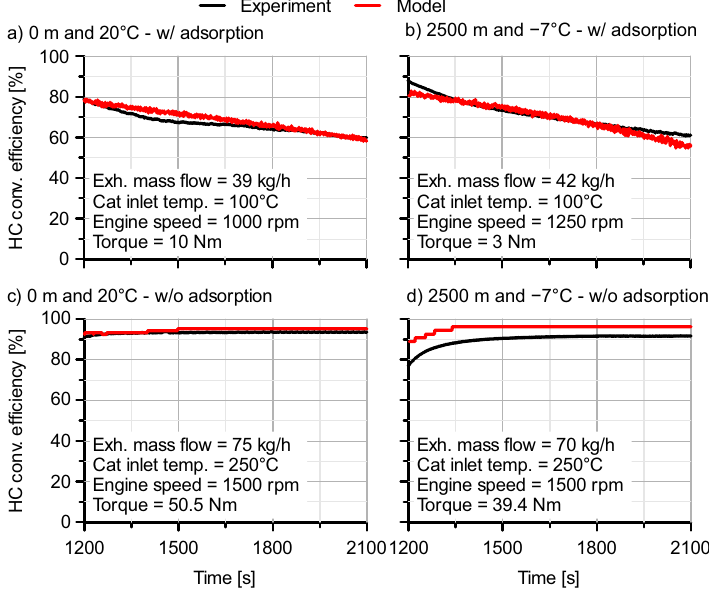
Figure 3. Comparison between experimental and modeled HC conversion efficiency during the tests at: ( a ) 0 m and 20 ◦ C with 39 kg/h in exhaust mass flow and 100 ◦ C in catalyst inlet temperature; ( b ) 2500 m and − 7 ◦ C with 42 kg/h in exhaust mass flow and 100 ◦ C in DOC inlet temperature; ( c ) 0 m and 20 ◦ C with 75 kg/h in exhaust mass flow and 250 ◦ C in catalyst inlet temperature; and, ( d ) 2500 m and − 7 ◦ C with 70 kg/h in exhaust mass flow and 250 ◦ C in DOC inlet